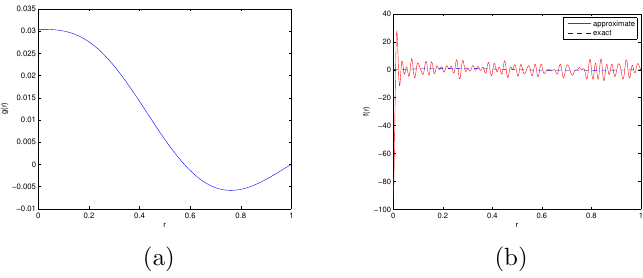
Figure 1. Example 1: (a) the input data g ( t ), (b) the direct computational result with noisy data